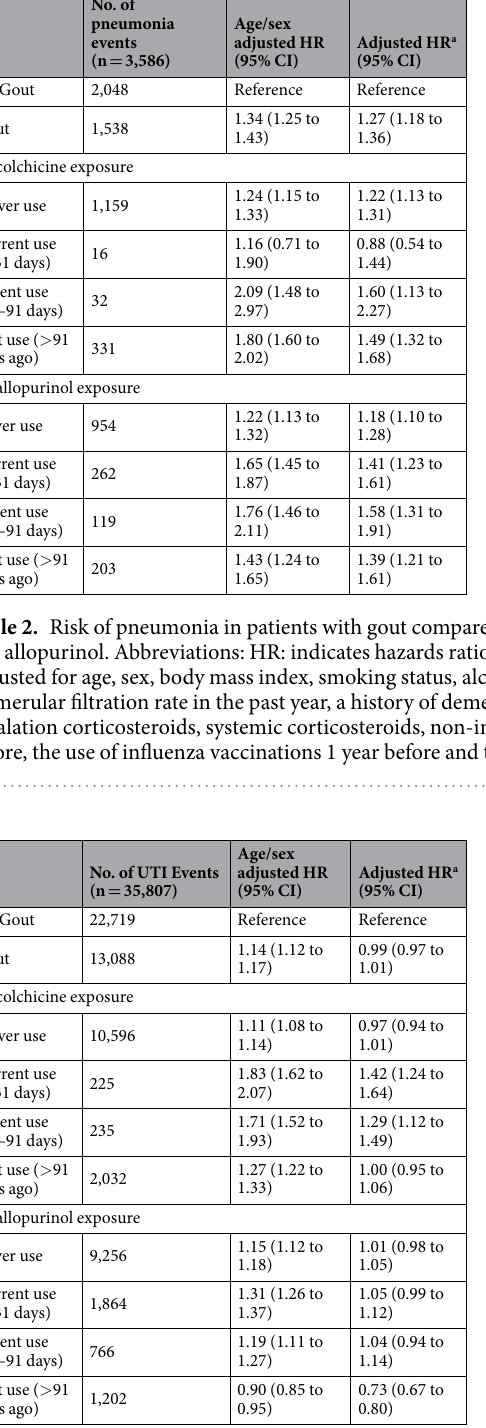
Table 3. Risk of urinary tract infection (UTI) in patients with gout compared to matched controls, stratified by use of colchicine and allopurinol. Abbreviations: HR: indicates hazards ratio; CI, confidence interval; PY, person years. (a) Adjusted for age, sex, body mass index, smoking status, alcohol use, the most recently recorded estimated glomerular filtration rate in the past year, a history of cancer, stroke and the use of an urinary catheter, systemic corticosteroids, non-insulin antidiabetic drugs and insulin 6 months